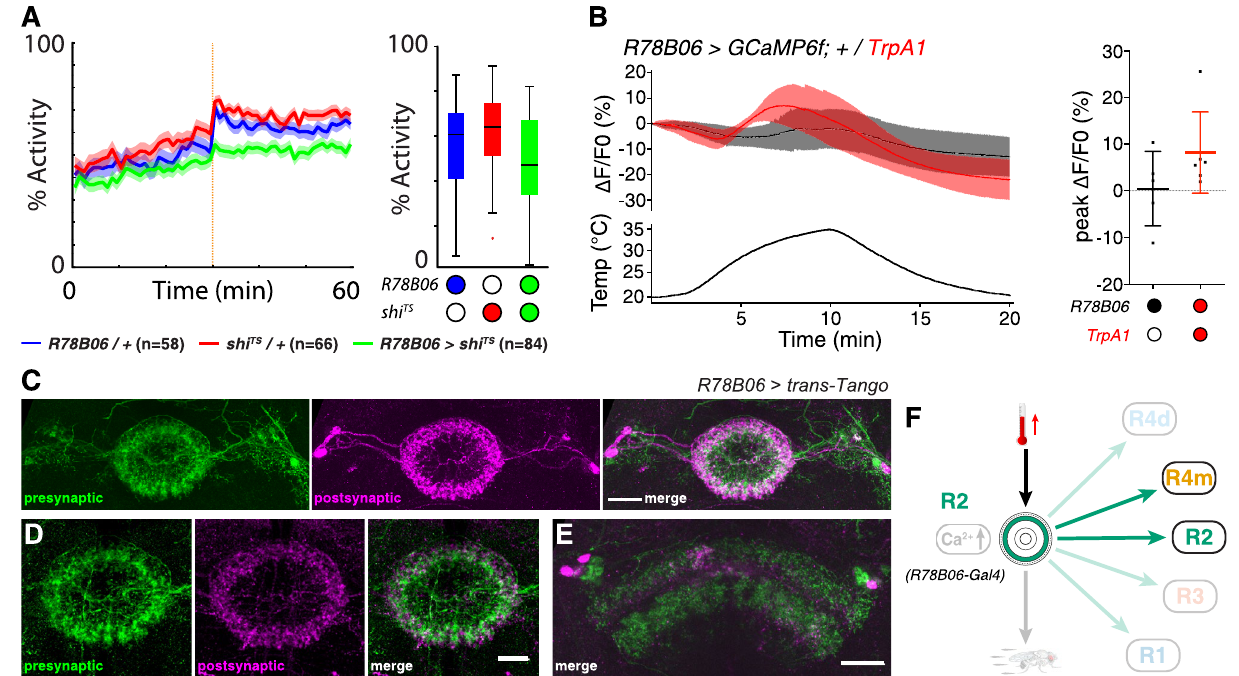
Figure 6. Connectivity and function of R2 ring neurons in thermoresponsive motor behavior. ( A ) Recorded at 31 °C, locomotor activity levels of R2— R78B06 > shibire TS flies (green) are comparable to Gal4 (blue) and UAS (red) controls (motor stimulation indicated by orange dashed line). Solid line, mean; shaded area, SEM; box and whiskers, median, IQR, Tukey. ( B ) Average (left) and peak (right) GCaMP imaging shows no temperature response in either controls or co-expressed TrpA1 for R2— R78B06 > GCaMP6f . Mean ± SD, n ≥ 5. ( C , D ) trans - Tango transsynaptic tracing of R78B06 - targeted R2 ring neurons reveals a reciprocal connection onto itself and to R4m. ( C ) Presynaptic signal (left, green), postsynaptic targets (middle, magenta) and merged image (right) of EB cell bodies and ( D ) detail of the ring neuropil. ( E ) trans -Tango imaging of R78B06-Gal4 labels specific layers of the fan-shaped body (FB) both pre- and postsynaptically (merged image shown). ( F ) R2 neurons connect to R2 and R4m EB rings; they neither integrate temperature increase nor mediate thermoresponsive motor behavior. Scale bars, 20 µm. See also Supplementary Figs. S1, S2 and